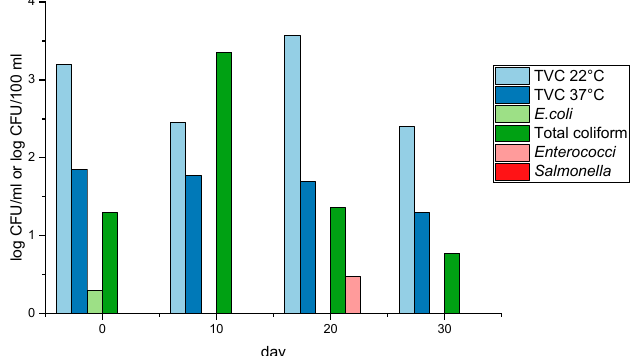
Figure 14. Microbiological indicators of rainwater (immediately after rainfall and 10, 20, 30 days after rainfall) used in the study.